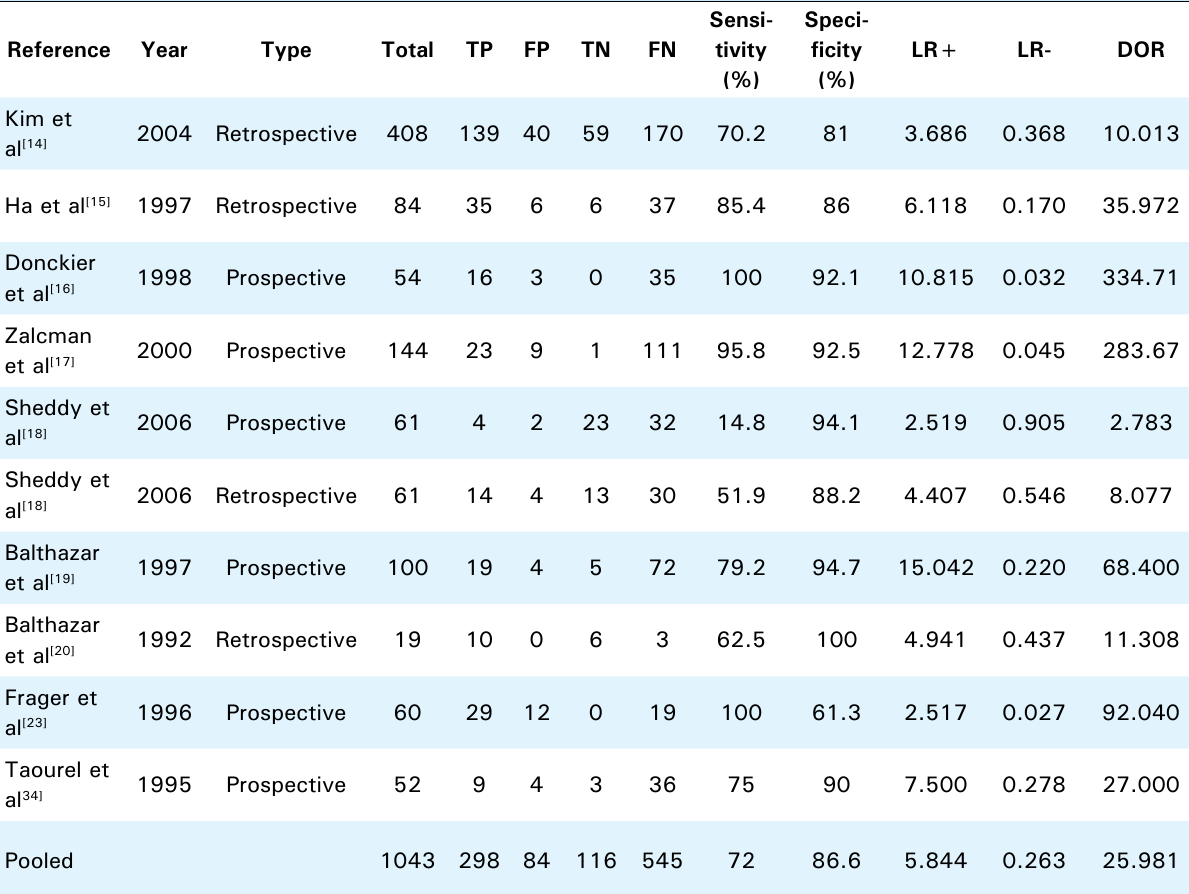
table 2. Prediction of pre-operative diagnosis of strangulation by